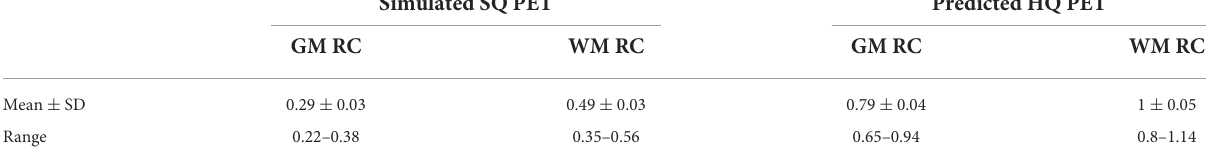
TABLE 2 Mean, standard deviation (SD) and range of the recovery coefficient (RC) for the gray matter (GM) and the white matter (WM) for predicted high-quality (HQ) PET and simulated standard-quality (SQ) PET in the test set.